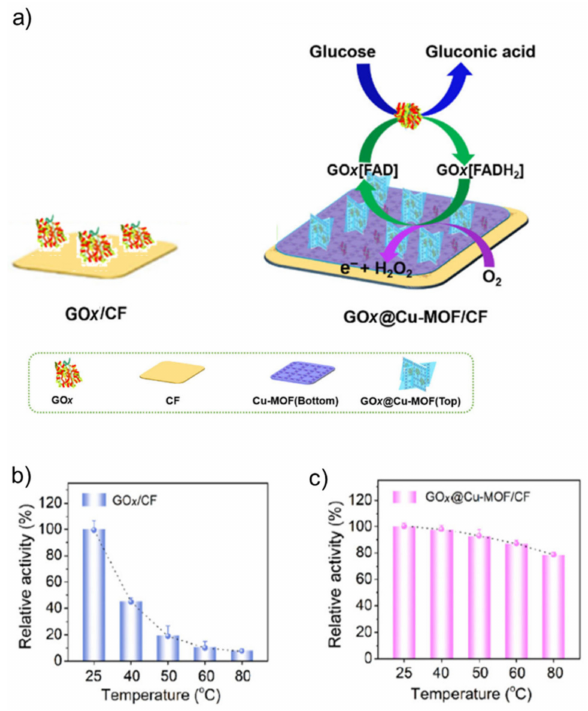
Figure 15. Chemoenzymatic cascade process as a new glucose biosensor. ( a ) Scheme of the bio-electrocatalytic cascade reaction; ( b ) Thermostability GOx / CF; ( c ) Thermostability GOx@MOF / CF. Figure adapted from Ref.